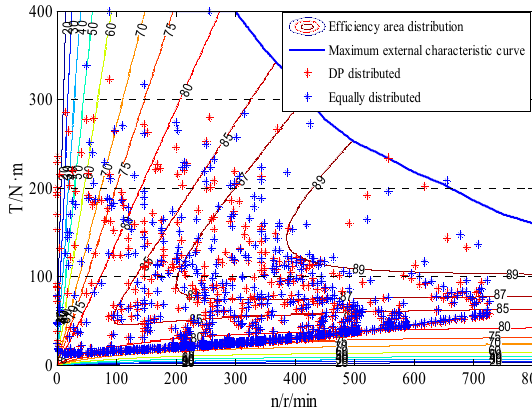
Figure 9. Torque distribution ratio map optimized by dynamic planning algorithm for the CUPDC.